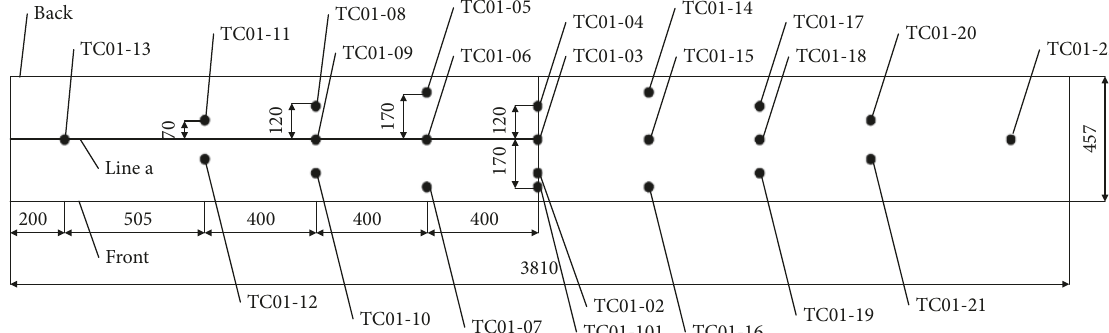
Figure 6: The temperature measurement positions of support bottom plate.